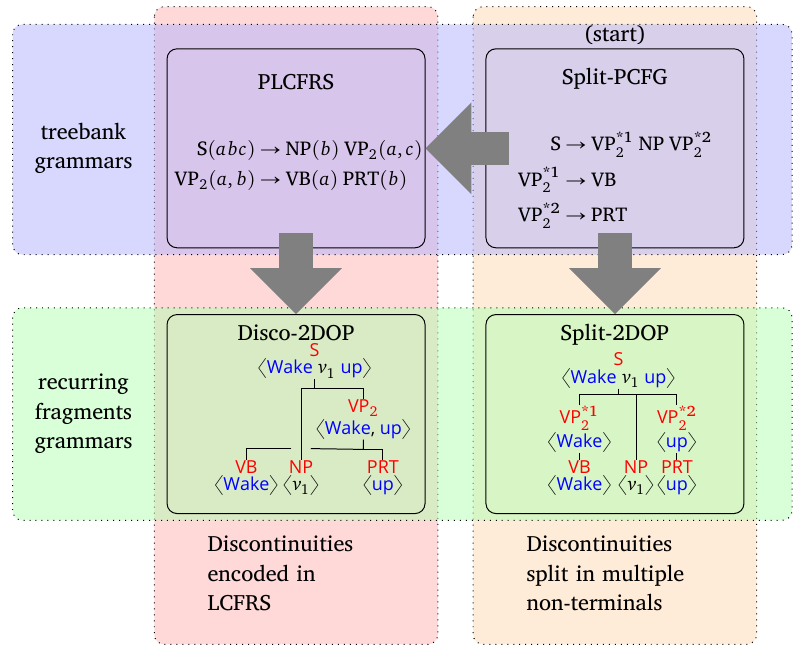
Figure 3: The systems explored in this work